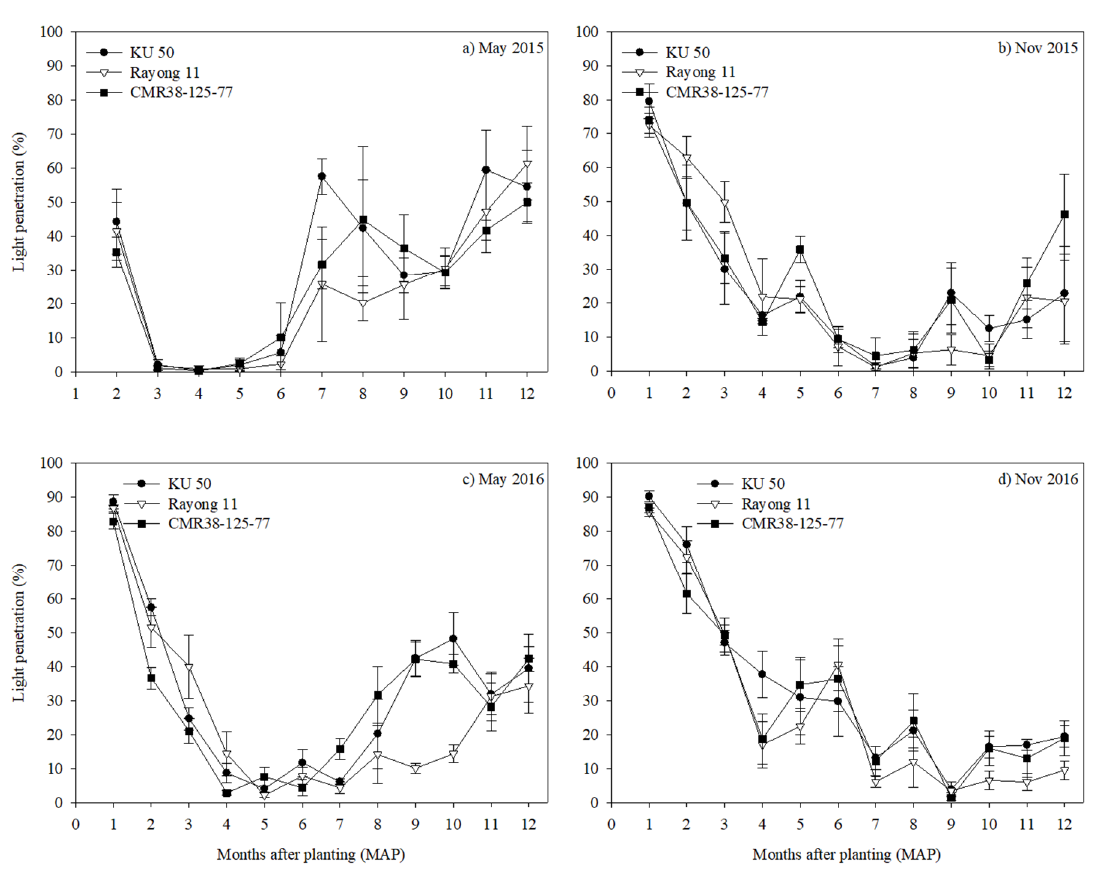
Figure 5. Light penetration of three cassava genotypes at planting dates May ( a ) and November ( b ) 2015 and May ( c ) and November ( d ) 2016. The bars indicate standard deviation of means.